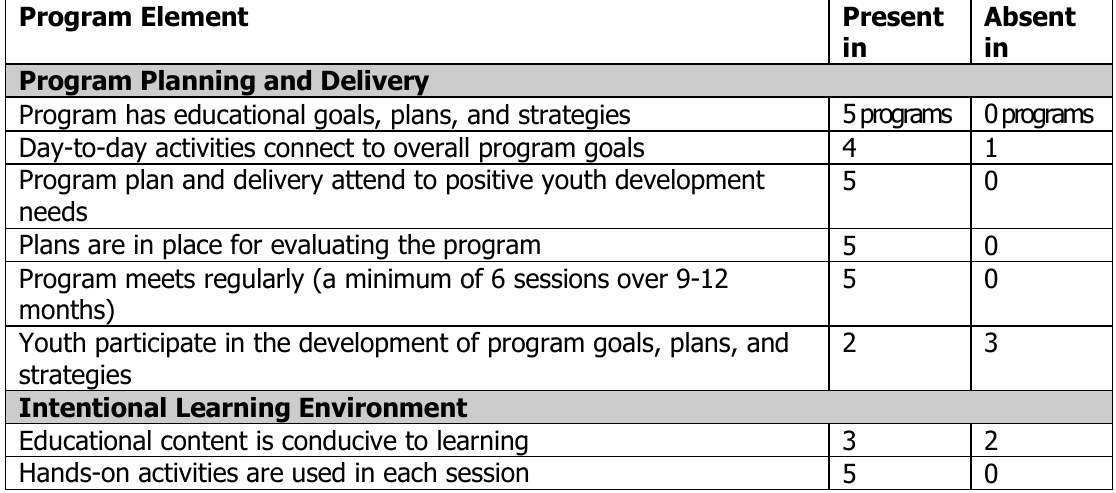
Learning Environment Survey